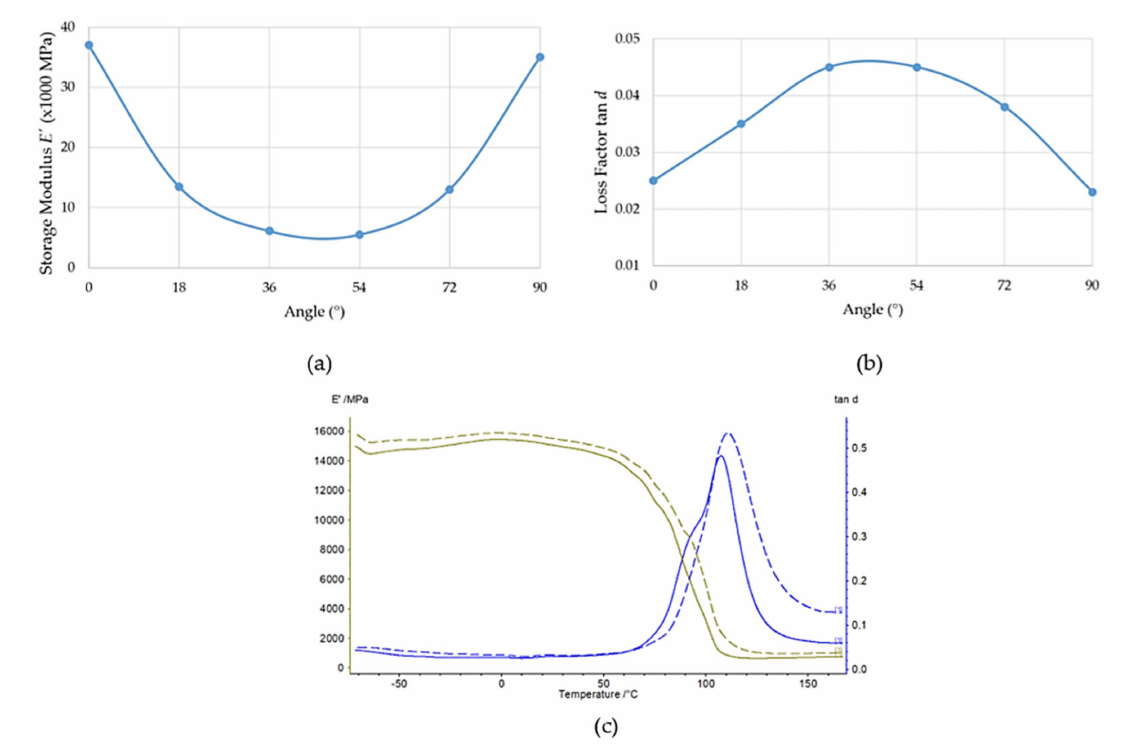
Figure 10. Effects of ( a ) E (cid:48) and ( b ) tan d on angle of warp fibres of Samples 13–18 for 60 ◦ C and a frequency of loading force of 1 Hz, and ( c ) DMTA plot of Sample 14 (bidirectional fabric, 18 ◦ ).